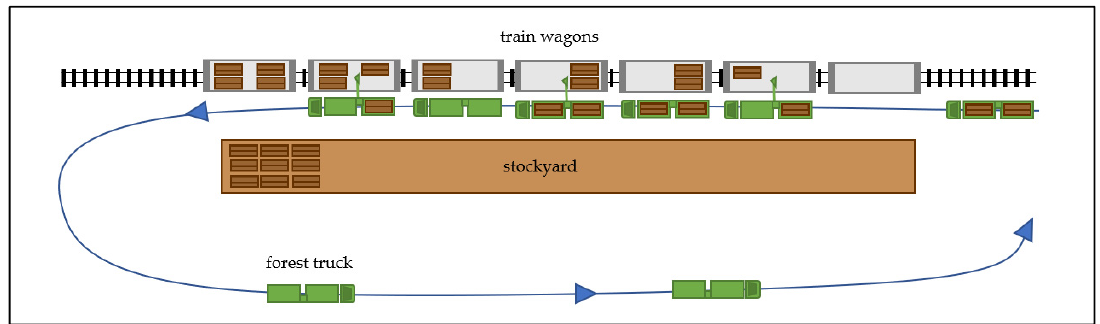
Figure 2. General layout of small scale train terminals displaying loading track, stockyard, and truck driving route.